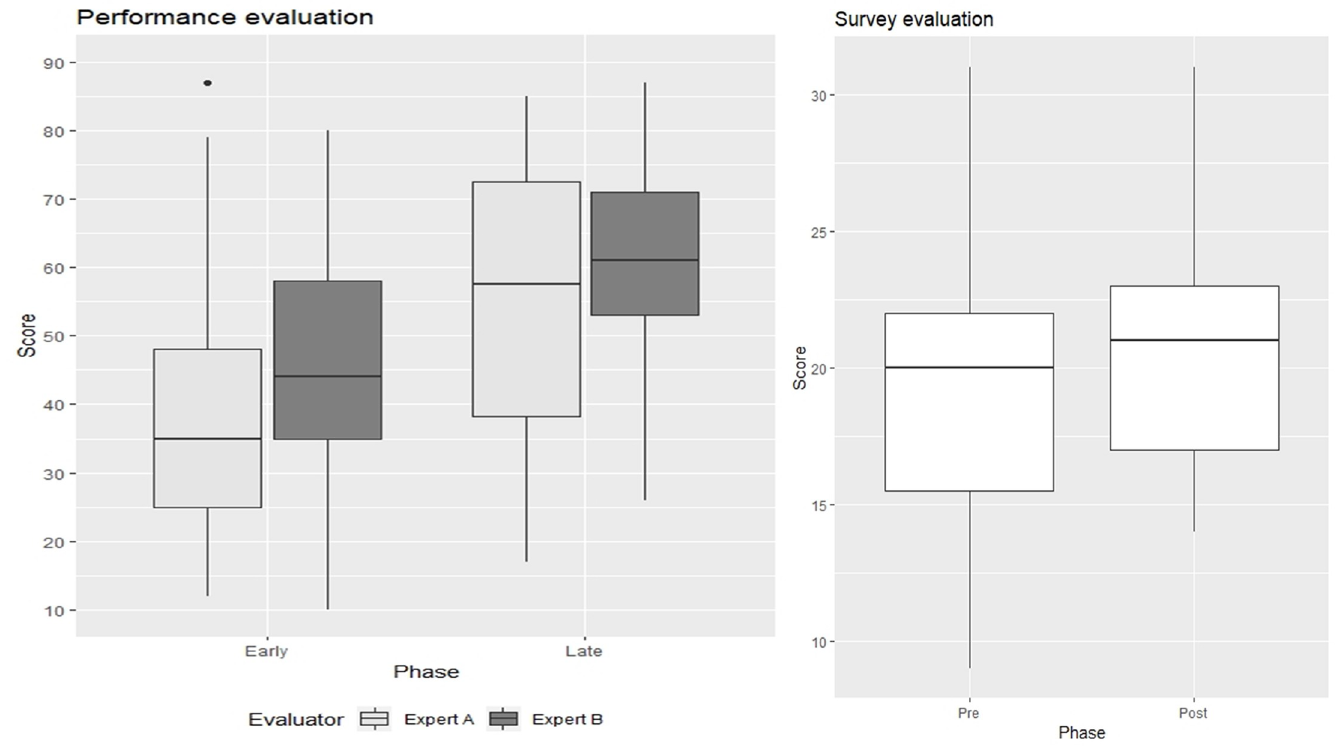
Fig 1. Evaluation of performance improvement in bedside cardiac ultrasound and survey about confidence and acceptance toward PoCUS. PoCUS, point-of-care ultrasound.